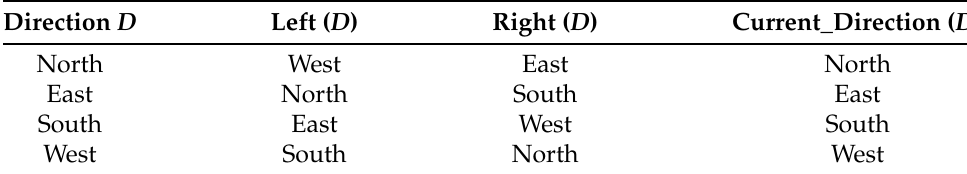
Table 1. Compass directions and “left”, “right”, and “current_direction”. Direction